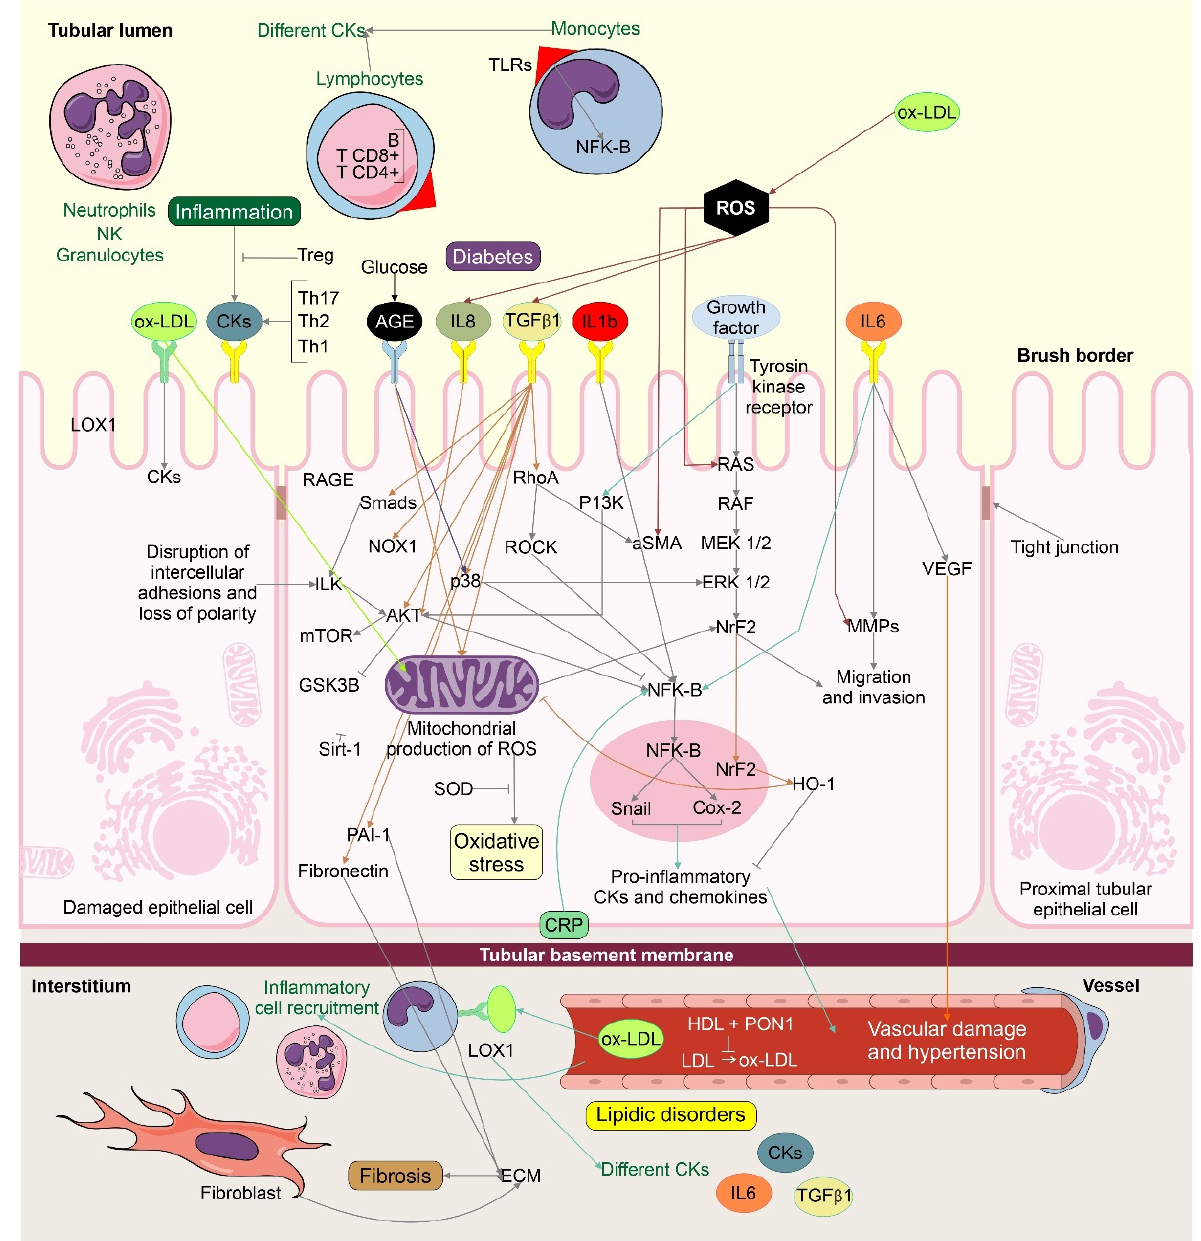
Figure 3. Alterations related to kidney injury, including diabetes, hypertension, and vascular damage (CVD and CAD) and the molecular mechanisms involved in inflammation, fibrosis, lipid disorders, and oxidative stress (highlighted in boxes). Some elements of this figure were taken from the Mind the Graph platform, available at www.mindthegraph.com (Last date of access; September 30, 2021)